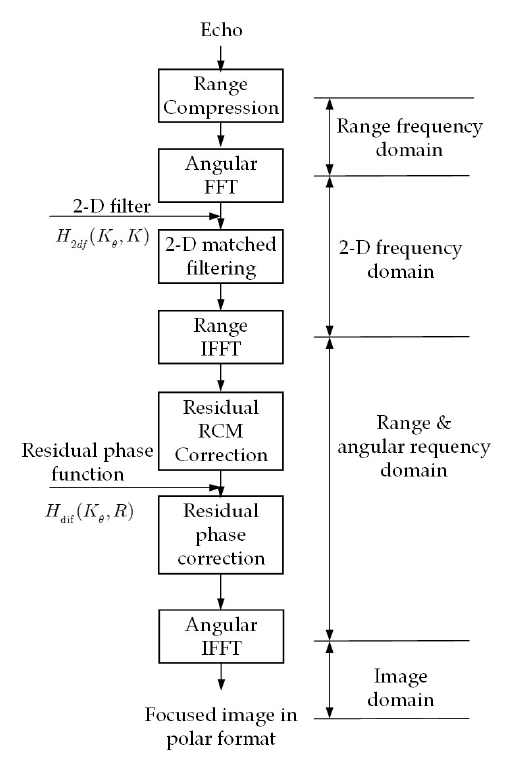
Figure 2. Flow chart of the proposed ArcSAR imaging